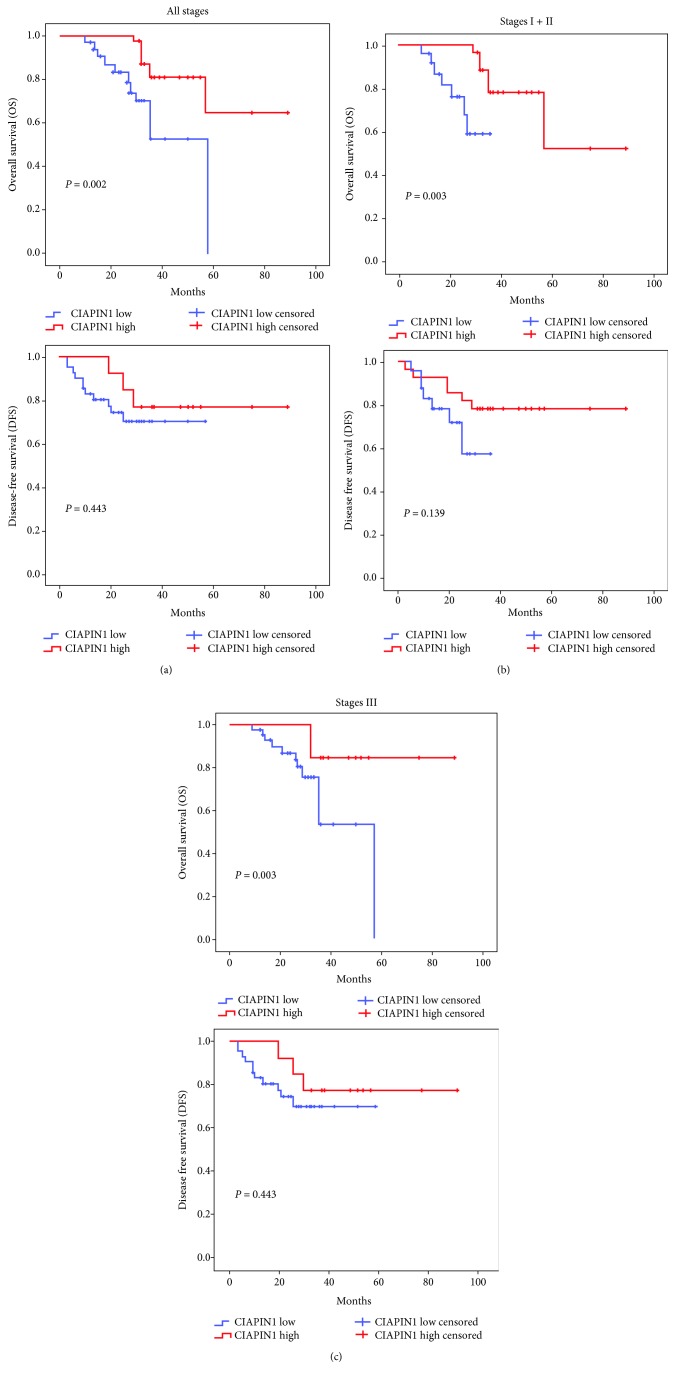
Good OS was correlated with CIAPIN1high NSCLC cancer patients. Kaplan-Meier survival curves based on high vs. low expression levels of CIAPIN1 in NSCLC patients. (a) Patients in all stages. (b) Patients in stages I and II. (c) Patients in stage III.